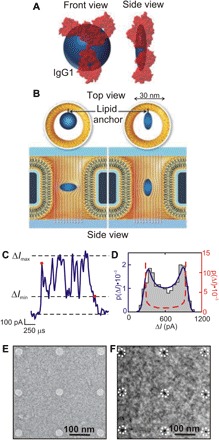
“5D” fingerprinting with a nanopore.Following Yusko et al., the approximate shape, dipole moment, and rotational diffusion coefficient are extracted from current modulations within individual current blockades from the translocation of a single protein through a 30-nm-diameter pore. (A) The approximate shape of the antibody immunoglobulin G1 (IgG1) protein as determined by analysis of individual resistive pulses (blue) with crystal structures in red (blue spheroids show the median values of m and volume from single event analyses of the protein). (B) Top and side views of a 30-nm-diameter nanopore illustrating the two extreme orientations of a spheroidal protein that is anchored to a fluid lipid coating on the pore wall. A crosswise orientation disturbs the field lines inside the pore more than a lengthwise orientation due to the angle-dependent electrical shape factor. Rotational dynamics of individual proteins inside a nanopore reveal a spheroidal approximation of the protein’s shape. (C) Current blockade from the translocation of a single IgG1 molecule. Red dots mark the beginning and end of the resistive pulse. (D) Distribution of all current values within this one blockade. The dark blue curve shows the solution of the model, p(ΔI), after a nonlinear least-squares fitting procedure, and the red dashed curve shows the estimated distribution of the blockade current, ΔI, values due to the distribution of shape factors, p(ΔIγ) [adapted from Yusko et al. (74)]. (E and F) Arrays of nanopores can be used to boost throughput. A transmission electron micrograph of a nanopore array fabricated using electron beam lithography and reactive-ion etching through a freestanding SiN membrane is shown in (E). The average pore diameter was 29 ± 3 nm [adapted from Verschueren et al. (146)]. A transmission electron micrograph of a 1.7 × 2.8–μm2 silicon nitride membrane 11.3 nm thick with an array of 2-nm-diameter nanopores sputtered on the same 200-nm pitch using STEM is shown.